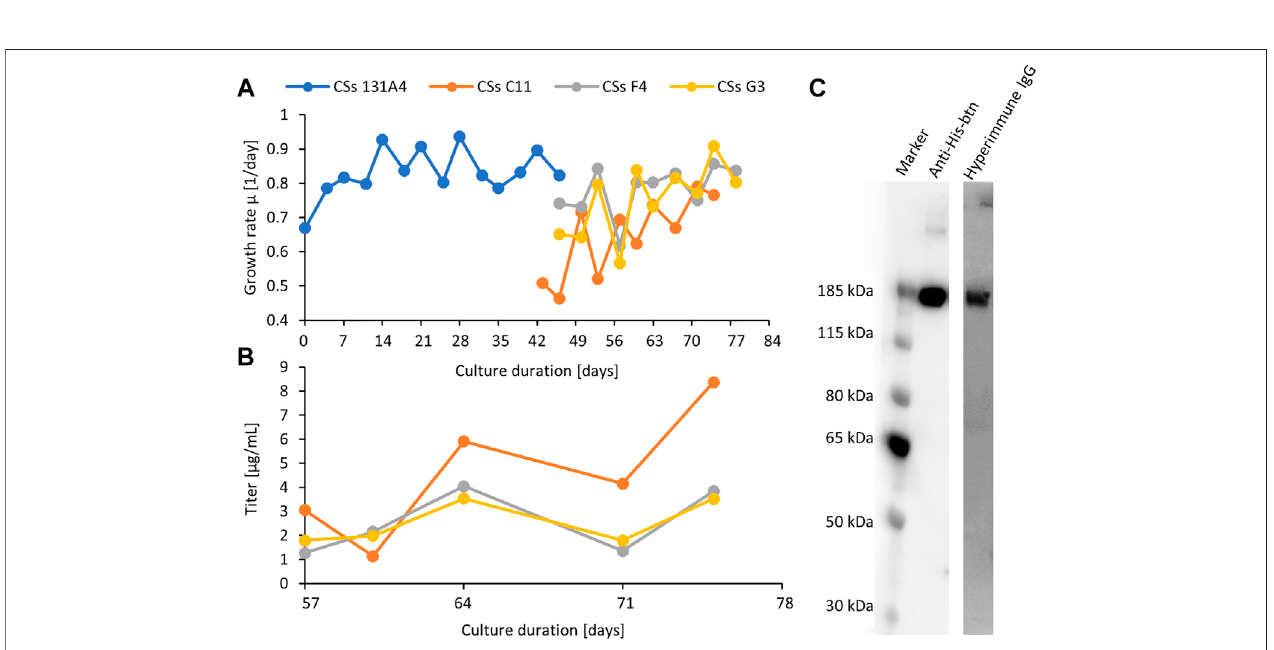
FIGURE 3 | Expansion and monitoring of growth (A) and productivity (B) of the fi rst parental clone CSs 131A4 and three fi nal CSs daughter clones in shake tube cultures. The clone CSsC11was selected asthe fi nal high-producing subclone. Anti-His and hyperimmune IgGWesternblotting (C) ofC11supernatant(12 μ l,100 ng) indicate the presence of the recombinant CSs protein in a structurally functional form to bind to speci fi c antibodies. Lane 1, anti-His-btn; lane 2, hyperimmune IgG-btn.